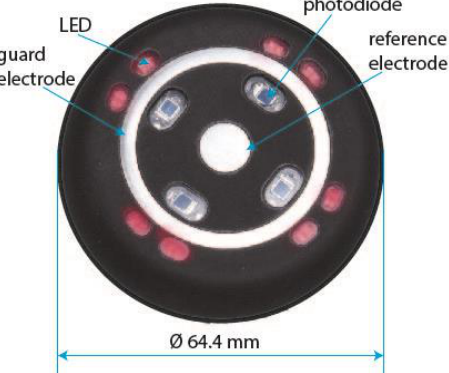
Figure 10. Implementation of the reference sensor with two electrodes and LEDs/photodiodes for SpO2